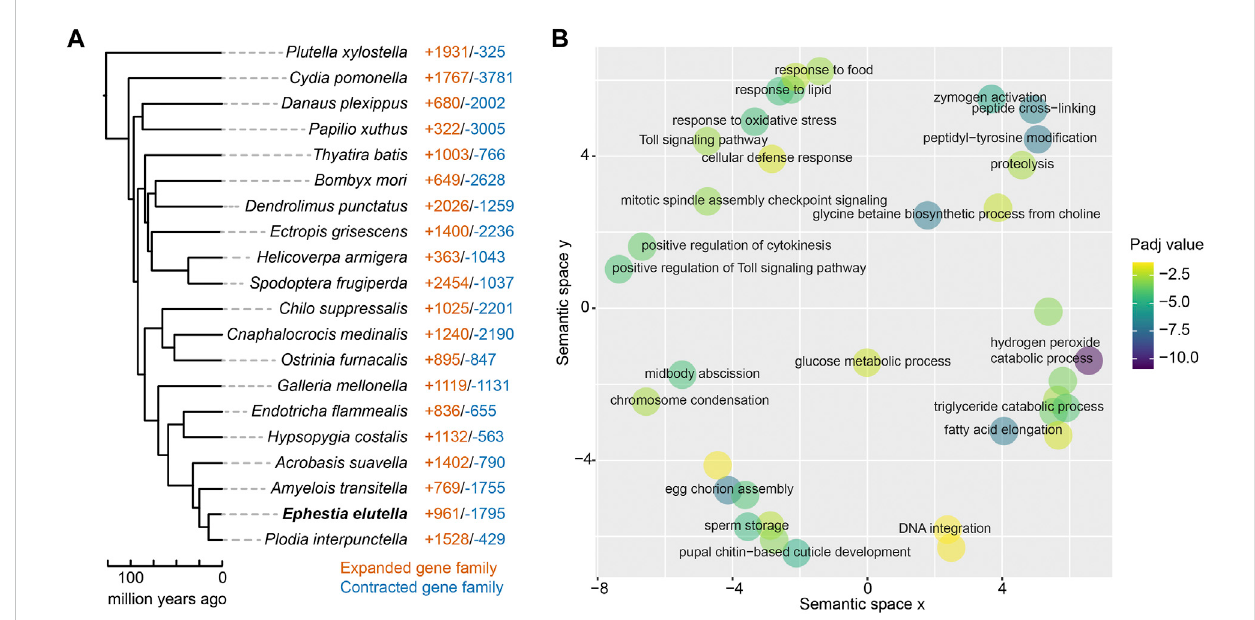
FIGURE 2 Gene family evolution of E. elutella . (A) The number of expanded gene families and contracted gene families on terminal branches of the lepidopteran phylogeny that obtained from Figure 1A. (B) GO terms of the E. elutella expanded gene families are summarized using